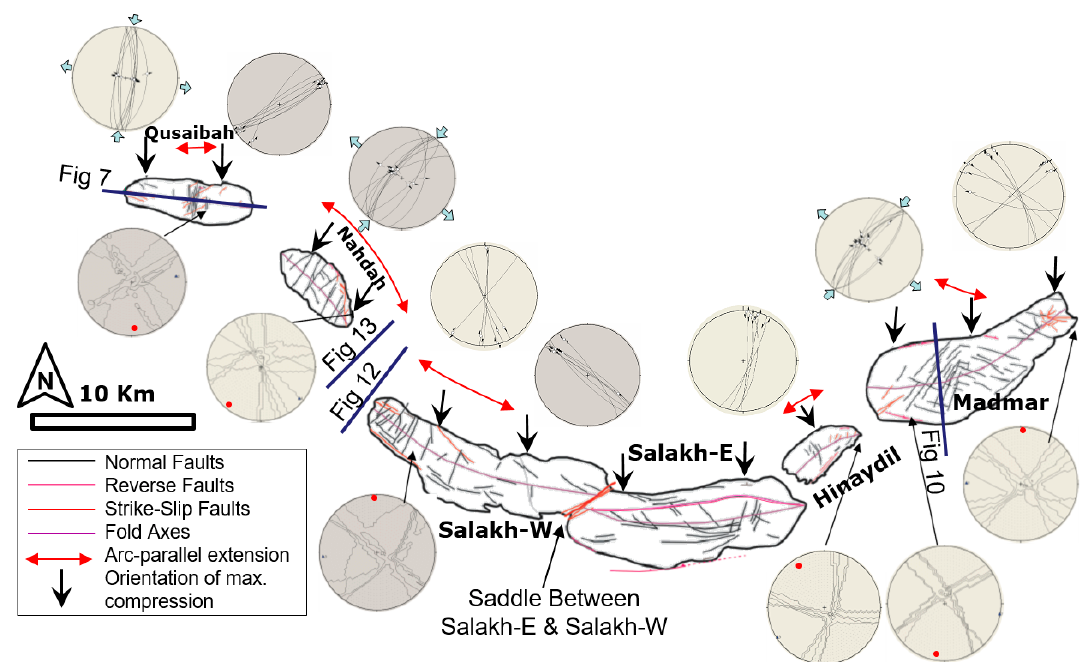
Figure 6. A summary of the structures in different segments of the Salakh Arch. The figure also highlights the areas (red arrows) that underwent arc-parallel or are-oblique extensions. The black arrows show the orientation of the maximum compression in various parts of the arch as suggested by the fold-axis orientations and/or the palaeostress analyses of σ -1 (showing as red dots in the palaeostress plots) from the kinematics of the strike-slip faults. The figure also shows the location of the surface and subsurface sections.